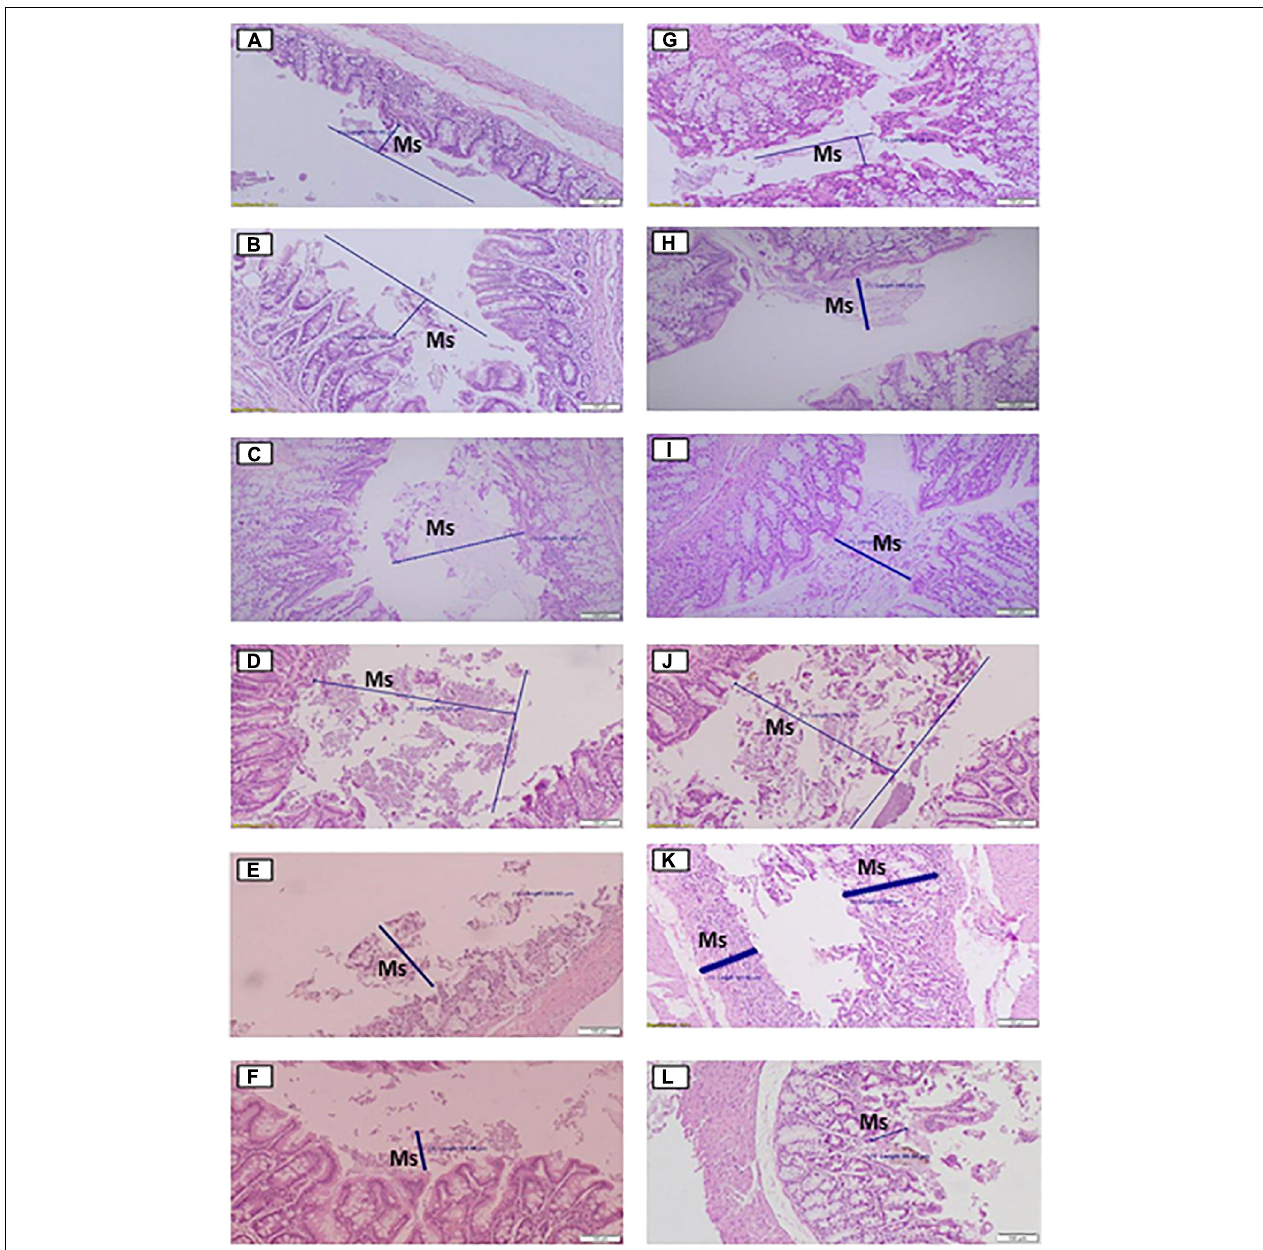
FIGURE 3 | Histological effects of the diets on mucus production in the cecum (A–F) and proximal colon (G–L) of rats fed for 35 days with different doses of Agave salmiana fructans. In addition, panels (A,G) are the control of the cecum and proximal colon, respectively, and panels (B,H) are the doses of 5%, with panels (C,I) of 10%, panels (D,J) of 12.5%, panels (E,K) of 15%, and panels (F,L) of 20%. Ms,